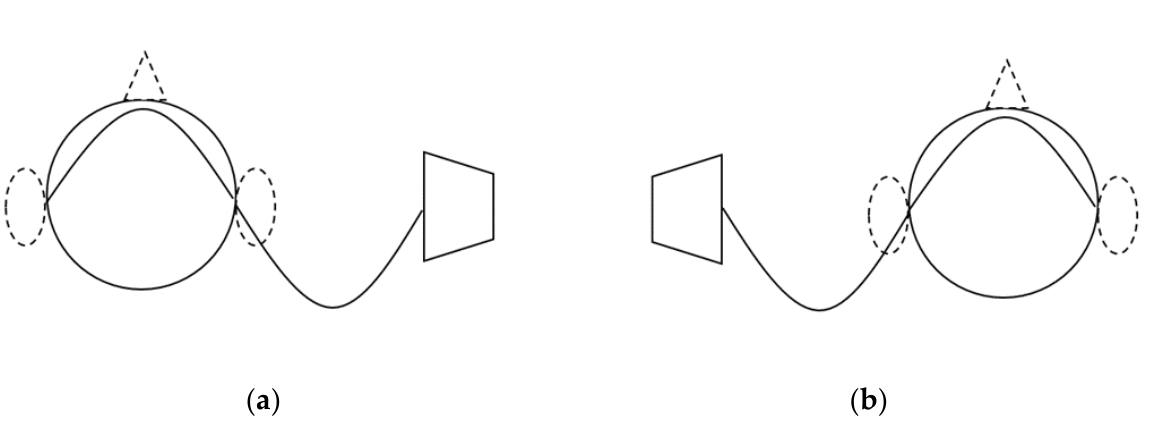
Figure 4. The maximum ITD: ( a ) The sound source is placed on the right-hand side. ( b ) The sound source is placed on the left-hand side.